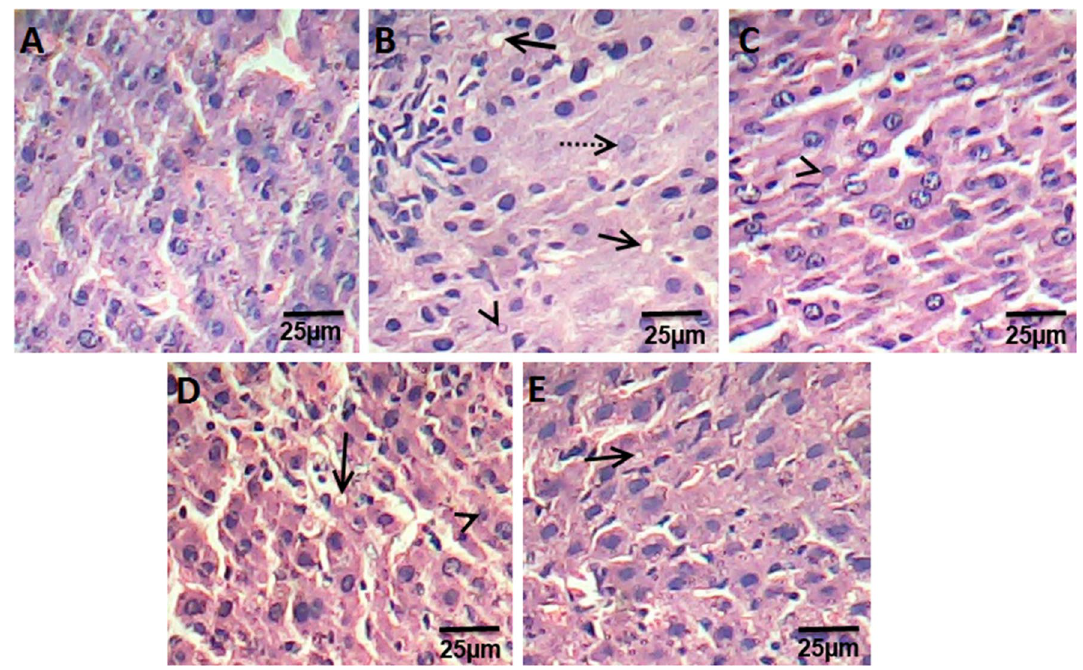
Fig. 2 Photomicrograph of hematoxylin and eosin stained liver sections from control rats group ( a ), HFD group ( b ), ATOR group ( c ), Ech group ( d ) and ATOR + Ech group ( e ) (H&E × 400). Solid arrow: fat droplets, dotted arrow: fibrosis, arrowhead: